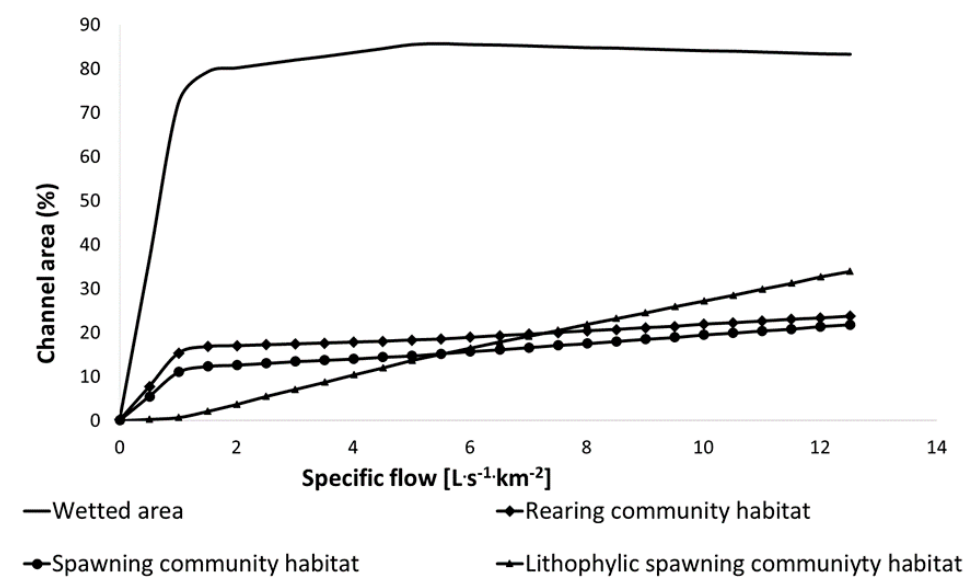
Figure 7. Habitat rating curves for bioperiod-specific fish communities in the Skawa River. Water 2018 , 10 , x FOR PEER REVIEW